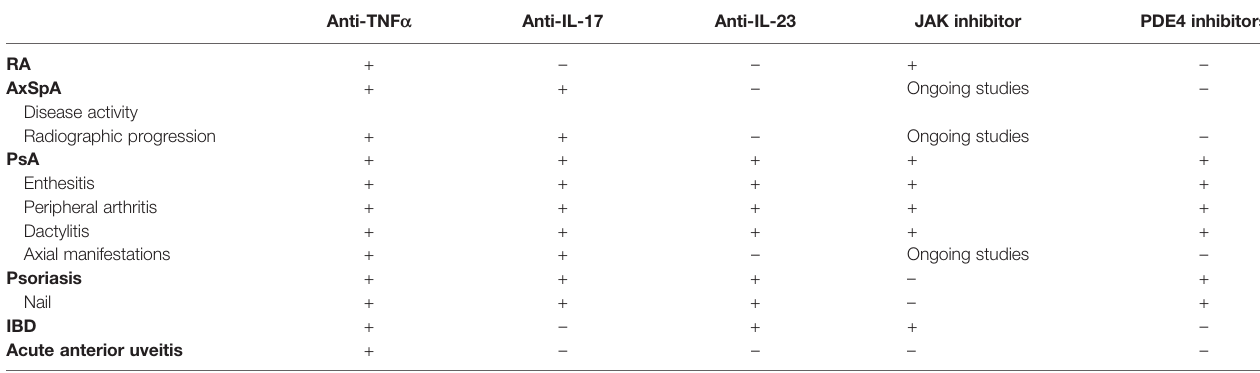
TABLE 2 | Comparison of different biologic class ef fi cacy in rheumatic diseases and disease